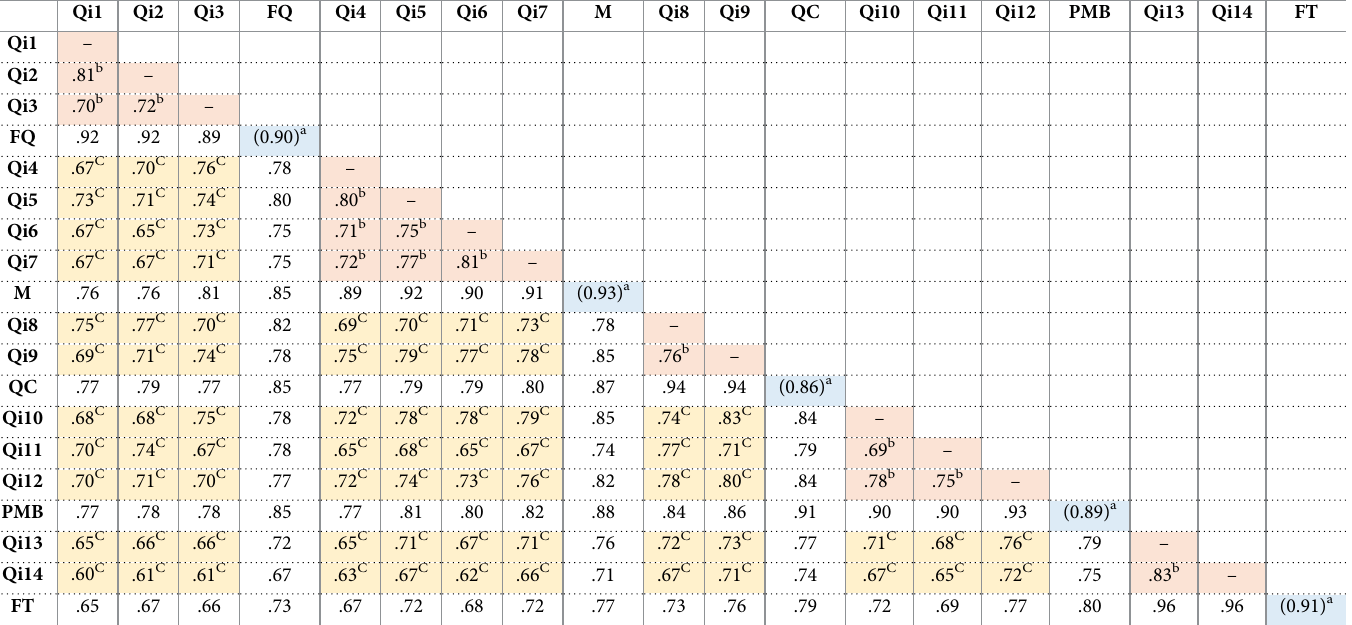
Table 3. Using the multi-trait-multi-method (MTMM) to determine the construct validity of the Qi